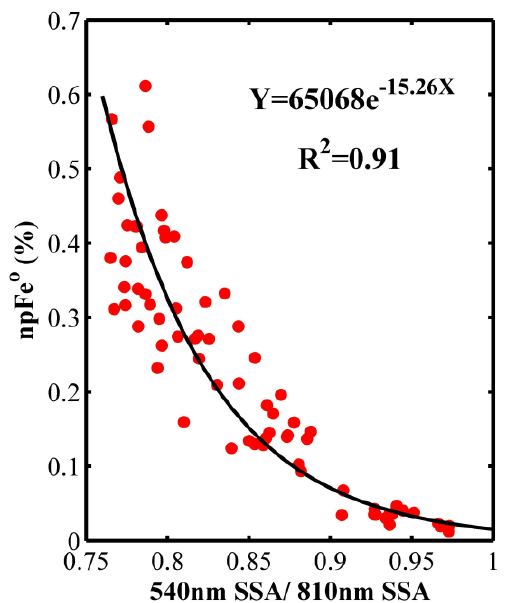
Figure 4. Correlation between the ratio of 540 nm SSA / 810 nm SSA and npFe 0 for all size groups of LSCC soil samples.